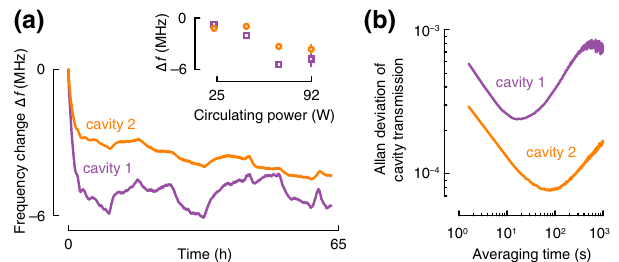
FIG. 7. The stability of the cavity lattices. (a) The change in the cavity resonance frequency (cid:8) f as a function of time for both cavities. At t = 0, we couple the laser beams into the cavities, which create a circulating power of approximately 92 W per cav- ity. We see a rapid initial decrease of 6 MHz, which corresponds to an expansion of the cavity length by 1 nm. Then, (cid:8) f settles and fluctuates with a peak-to-peak amplitude of approximately 2 Hz. The inset shows (cid:8) f as a function of the circulating power for cavity 1 (squares) and 2 (circles). Here, (cid:8) f is extracted by fit- ting the trace of the first hour to an exponential function. (b) The fractional intensity variation of the cavity transmission plotted as a function of